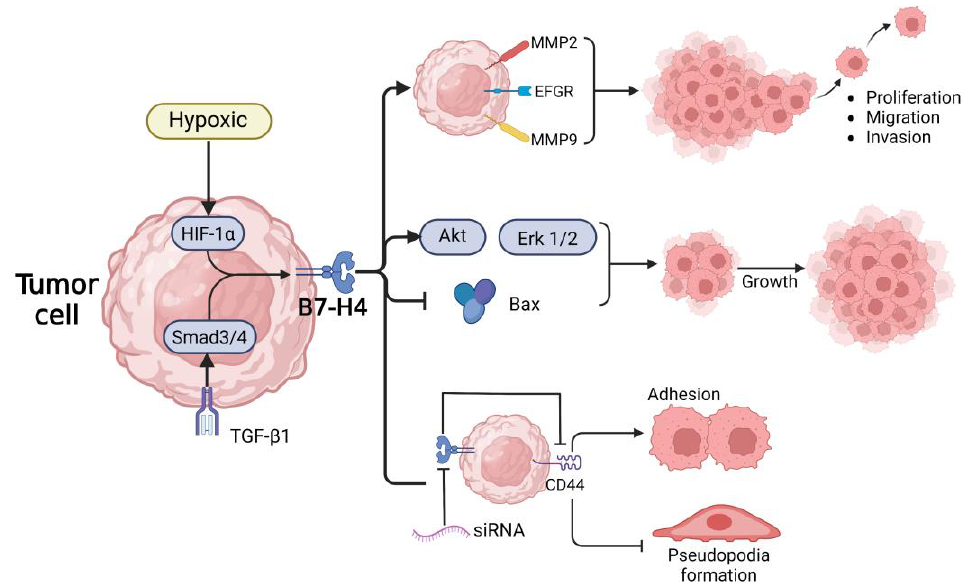
Figure 3. B7-H4 promotes the progression of pancreatic cancer. B7-H4 can promote the progression of pancreatic cancer cells through multiple pathways, promoting the growth, migration, and invasion of pancreatic cancer cells independent of its immunological effects.